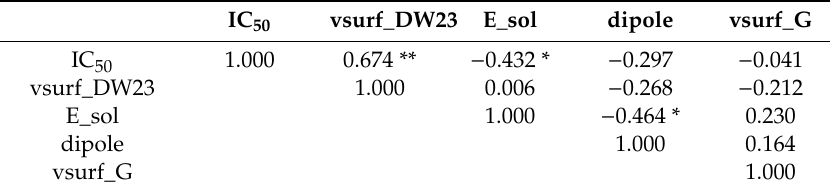
Table 3. The Pearson correlation between IC 50 and related descriptors.